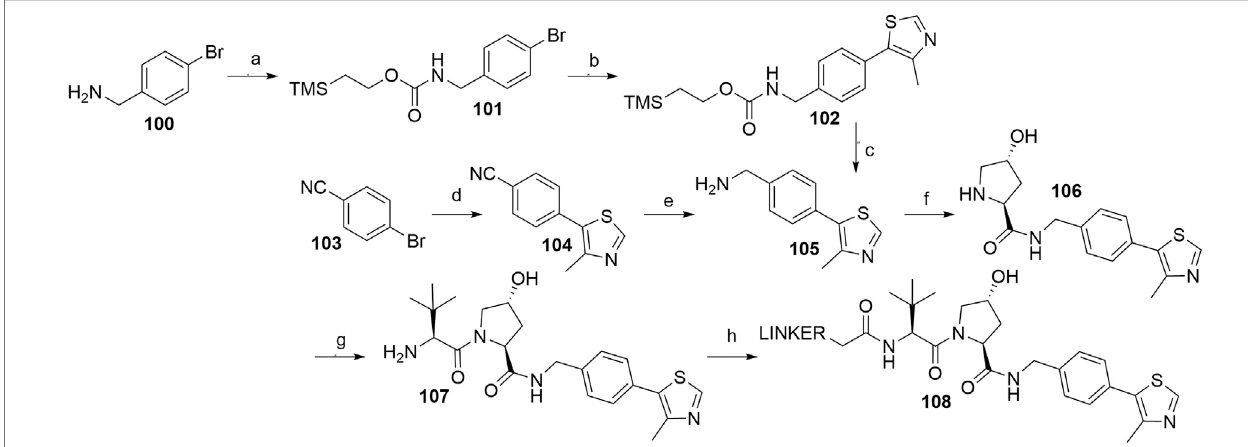
SCHEME 21 | Syntheses of VHL ligand 107 . Reagents and conditions: a) Teoc-OSu, Et 3 N, DMF, H 2 O, rt, 16 h, 84% yield; b) 4-methylthiazole-5-carboxylic acid, Pd(P( t